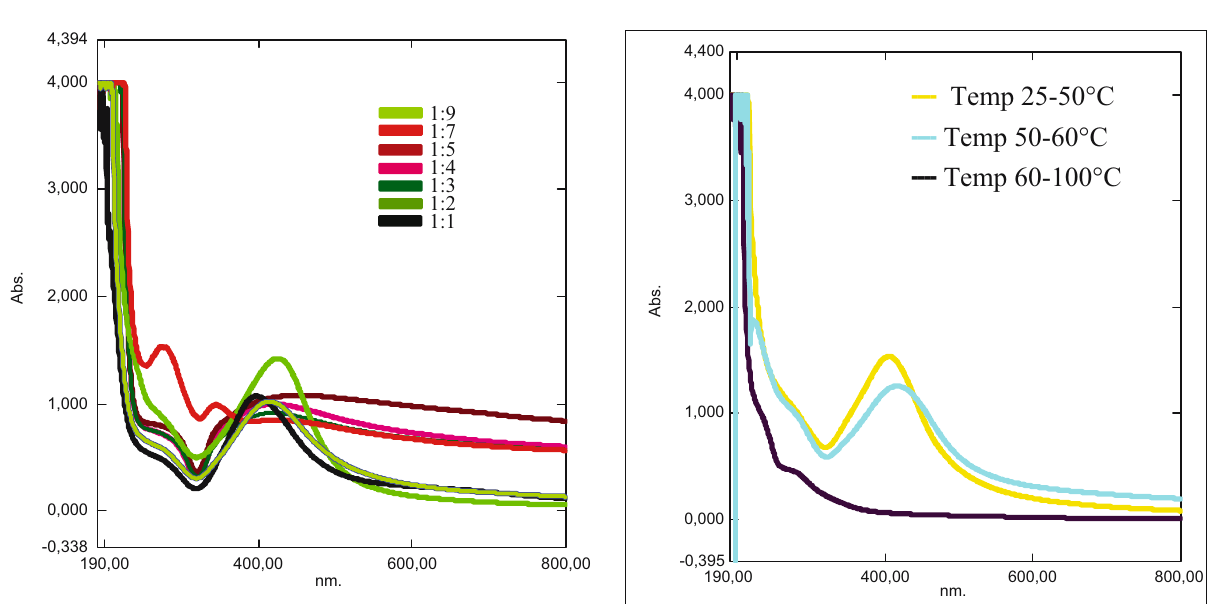
Figure 5: UV - spectra showing the e ff ect of thermal stress on the deformation and synthesized of AgNPs of T. govanianum